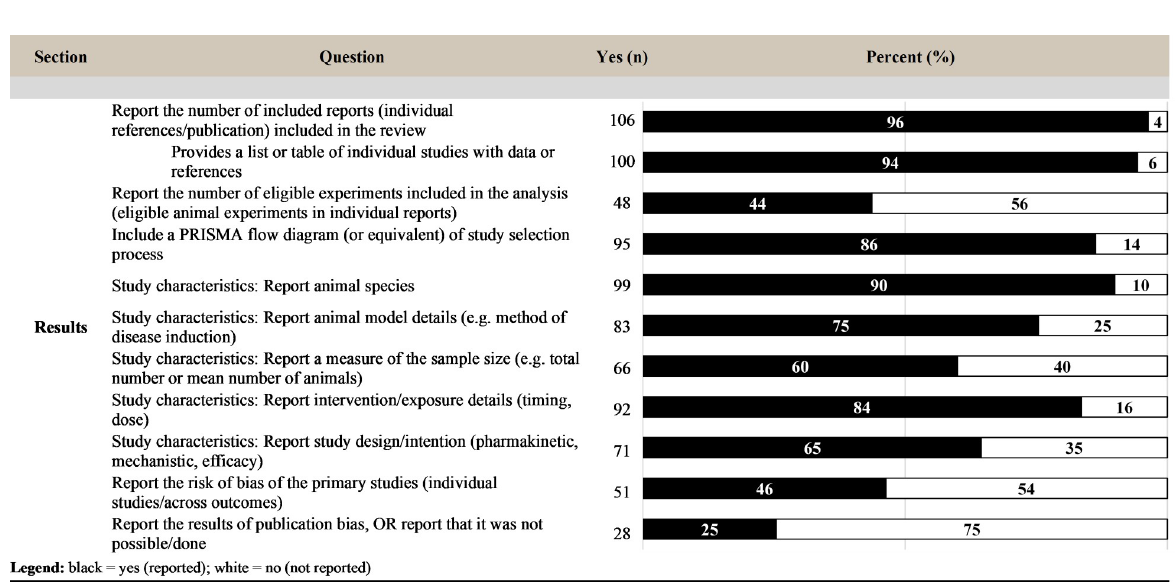
Fig 7. Level of reporting (count and percent) for the items within the results section. PRISMA, Preferred Reporting Items for Systematic reviews and Meta-Analyses.